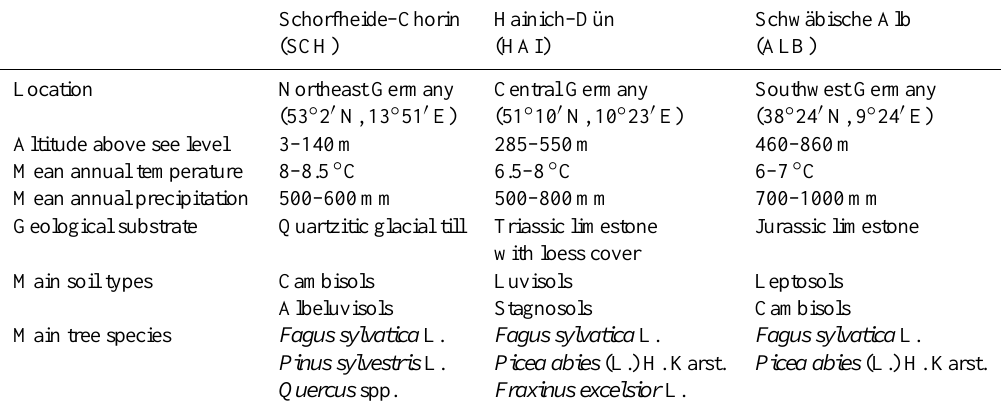
Table 1. Environmental properties of the study regions (mainly given by Fischer et al., 2010; soil classification according to IUSS Working group WRB, 2006).